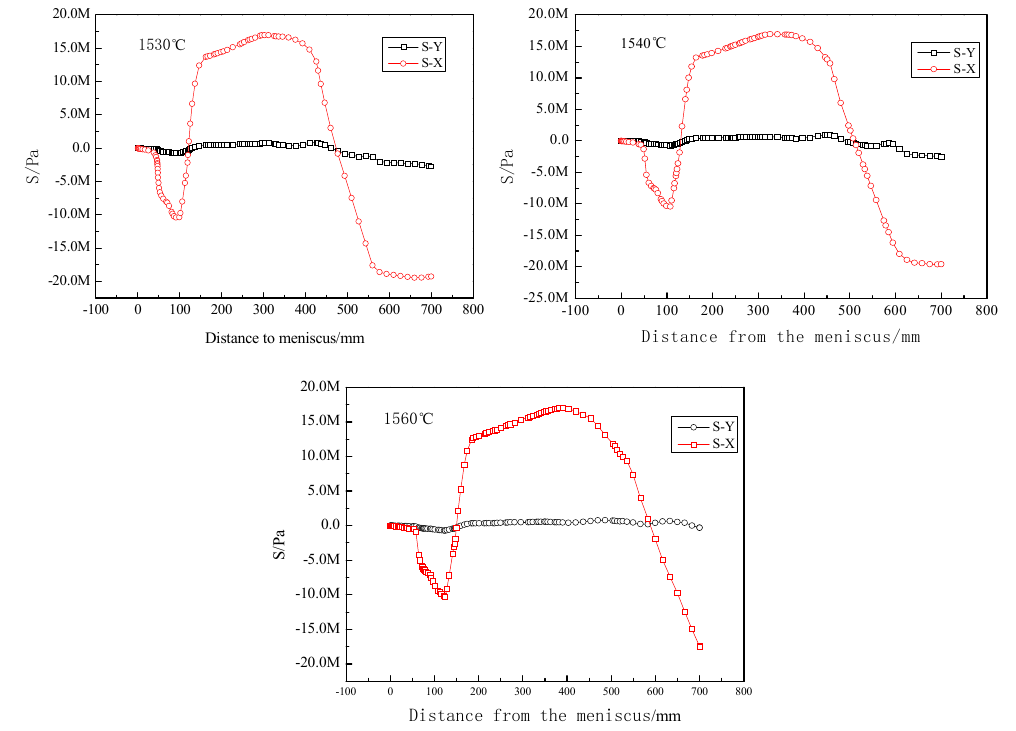
Figure 17. Stresses on the web at different pouring temperatures.